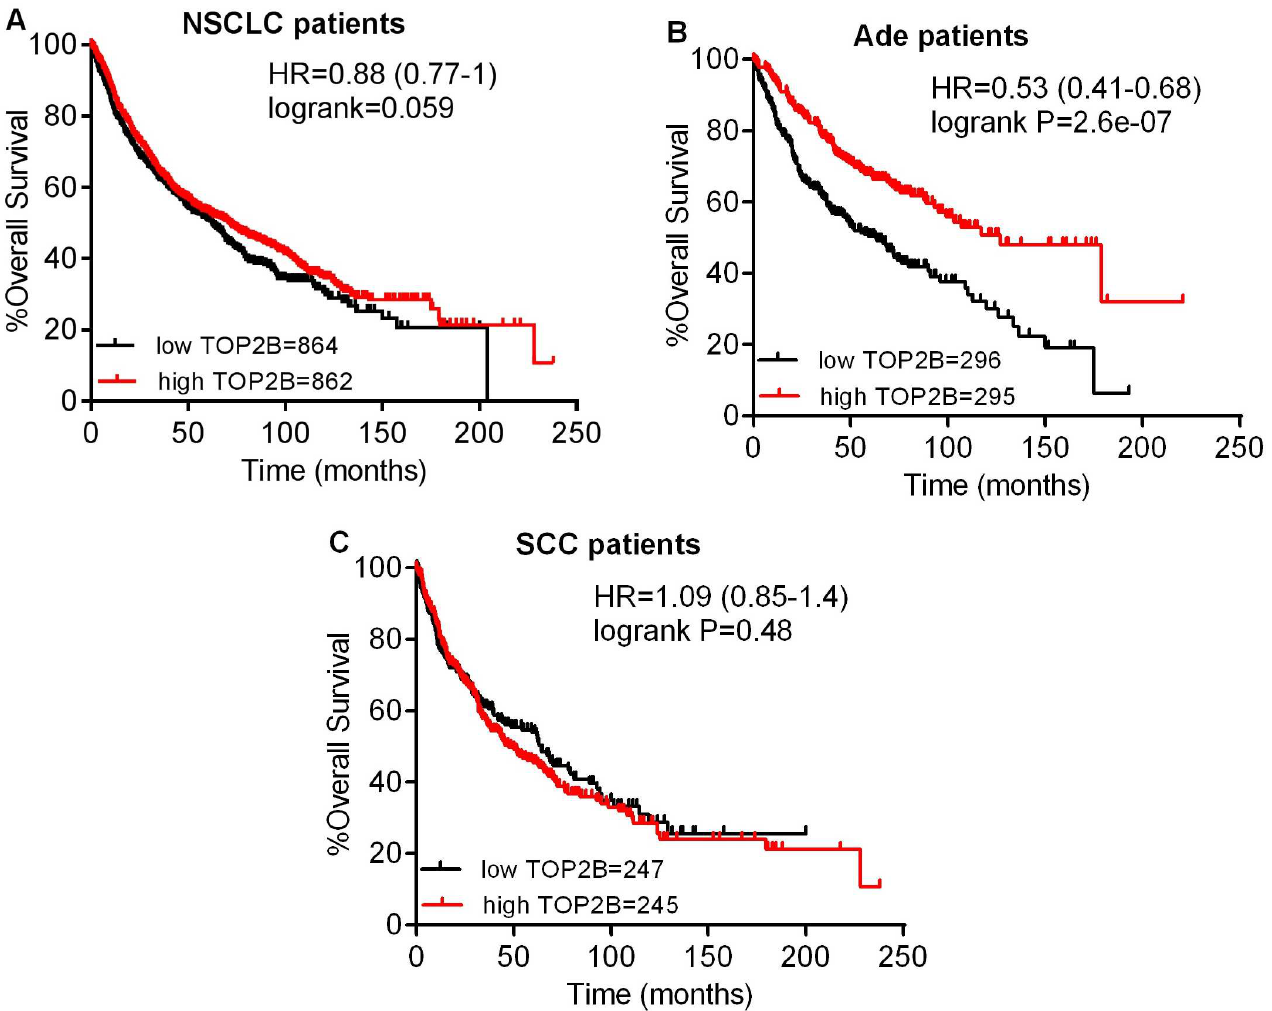
Fig 5. The prognostic value of TOP2B expression. (A) Survivalcurves were plotted for all NSCLC patients (n = 1726). (B) Survival curves were plotted for Ade patients (n = 591). (C) Survivalcurves were plotted for SCC patients (n = 492). Data was analyzedusing Kaplan-Meier Plotter. Patients with expressionabovethe median are indicatedin red line, and patients with expressions below the medianin black line. HR means hazard ratio.